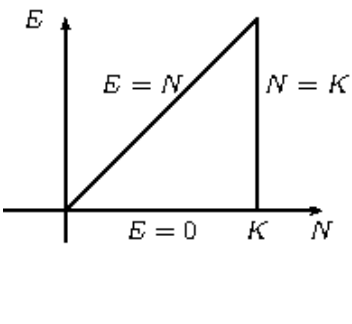
Fig. 2 A two-dimensional cross section of the positively invariant